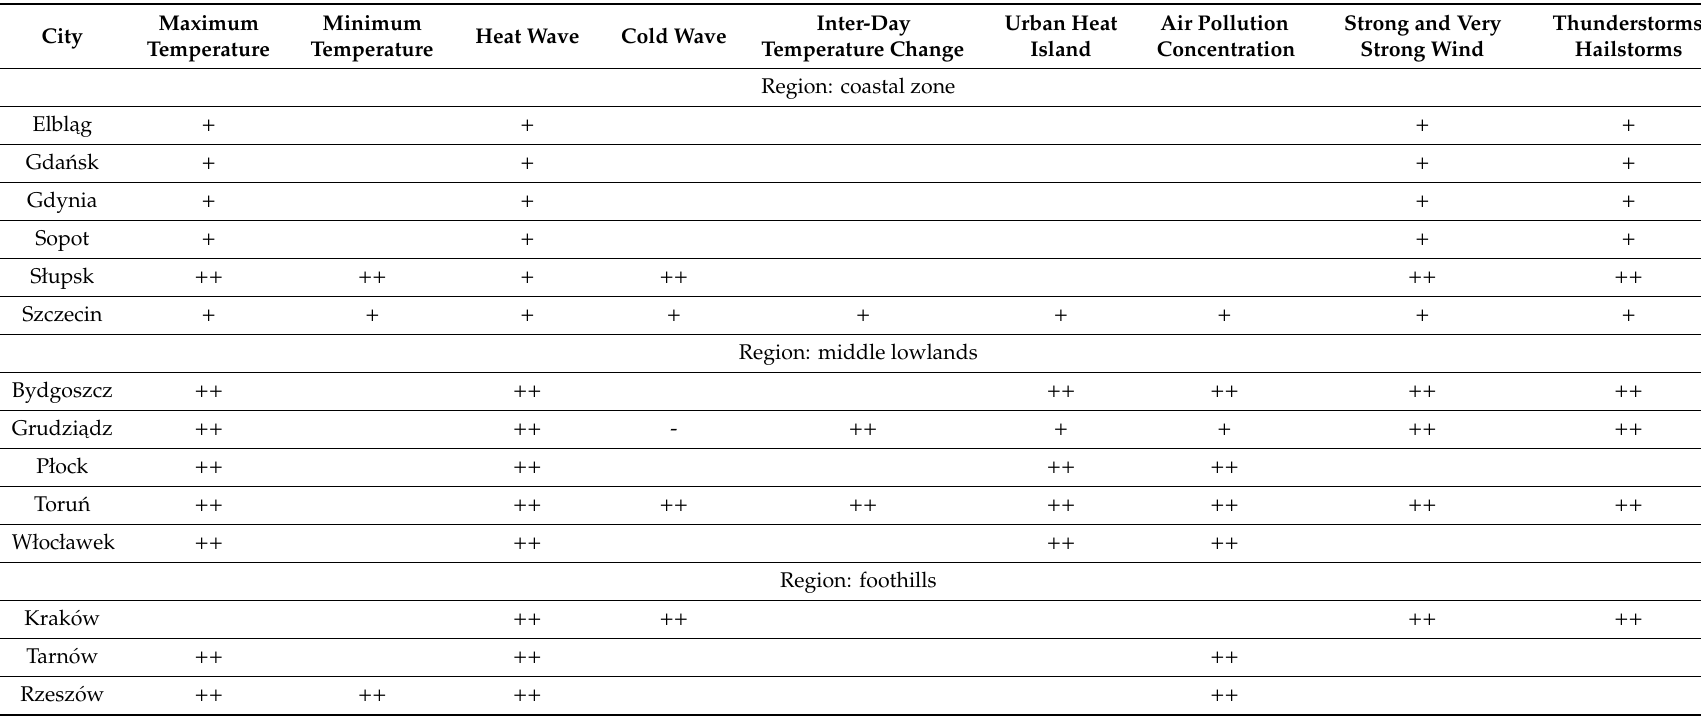
Table A1. Identified climate phenomena that pose a climate risk in selected cities in Poland (based on the MAPs of 14 cities up to 2030). Part I. City